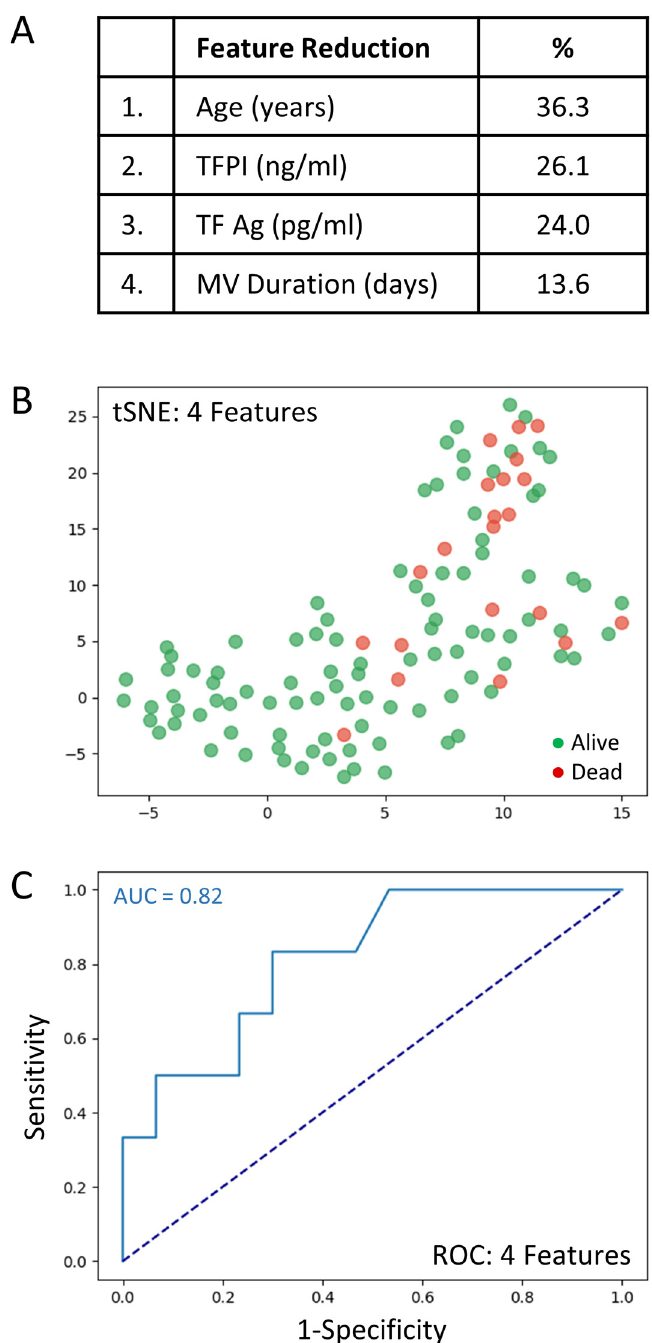
Figure 3. The top four clinical variables associated with COVID-19 patient mortality. ( A ): Feature reduction demonstrating the top four patient variables that classify COVID-19 outcome status, dead or alive, with their % association. ( B ): COVID-19 patients plotted in two dimensions following dimensionality reduction in their top four patient variables by stochastic neighbor embedding (tSNE). Red dots represent COVID-19 patients that died, whereas green dots represent COVID-19 patients that survived. The dimensionality reduction shows that based on the top four patient variables, the two cohorts are distinct and separable. The axes are dimensionless. ( C ): Receiver operating characteristic (ROC) curve analysis of COVID-19 patient outcomes, dead or alive, using the top four patient variables, demonstrates an area-under-the-curve (AUC) of 0.82. The diagonal broken dark blue line represents chance (AUC 0.50). The cut-off values were: age > 69.5 years; TFPI > 35.1 ng/mL; TF Ag > 80.4 pg/mL; and mechanical ventilation duration >1 days.